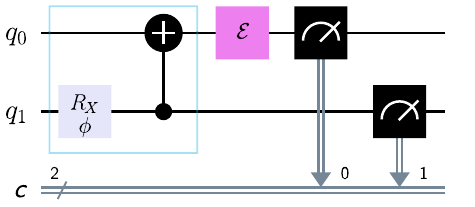
FIG. 1. Quantum-circuit representation of the AATPM scheme. The two-qubit operation in the blue box creates the purified state, Eq. (9), that both prepares the main qubit q 0 in a thermal mixture, and imprints the information about its state in the ancilla qubit q 1 . The main qubit evolves according to a generic map E , pink box. Finally, both qubits are read, providing information about the state of the main qubit before and after the evolution.